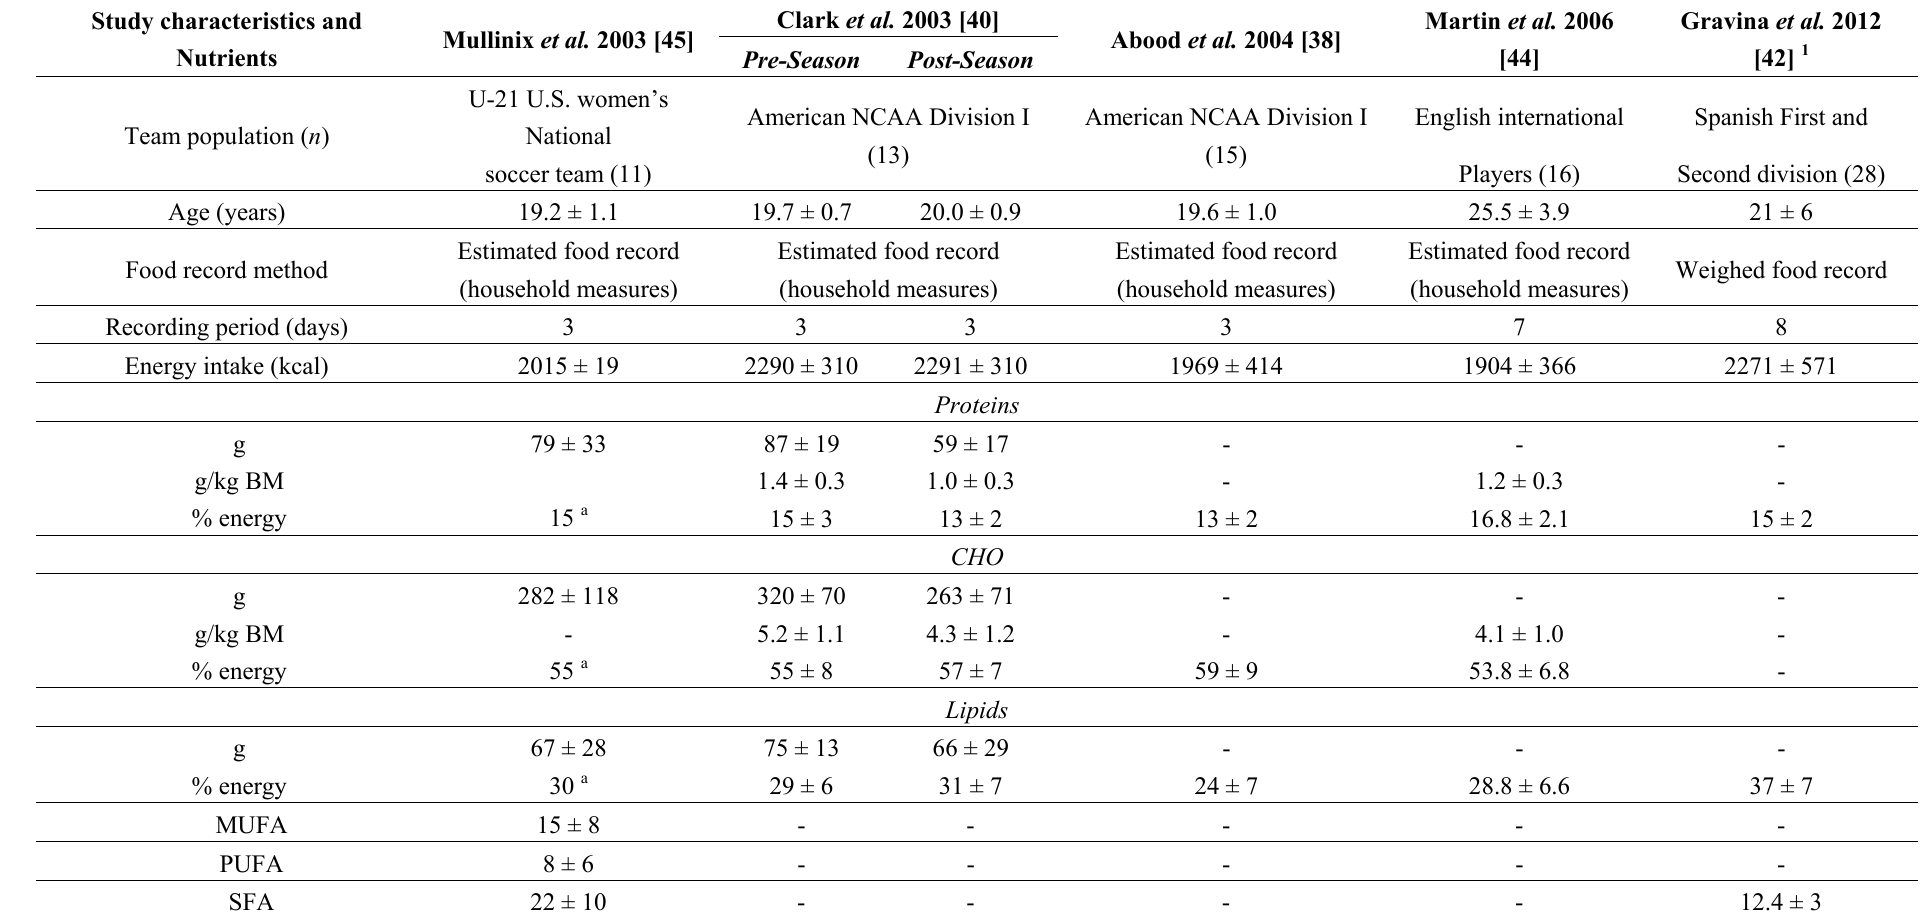
Table 2. Studies analyzing the nutritional intake of female soccer